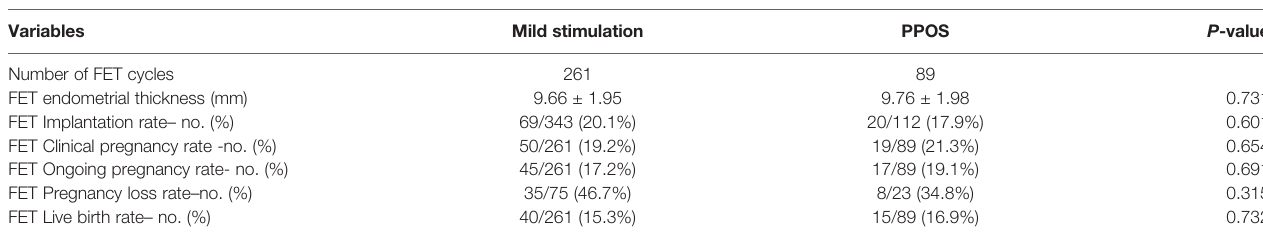
TABLE 3 | Clinical FET outcomes of both groups.